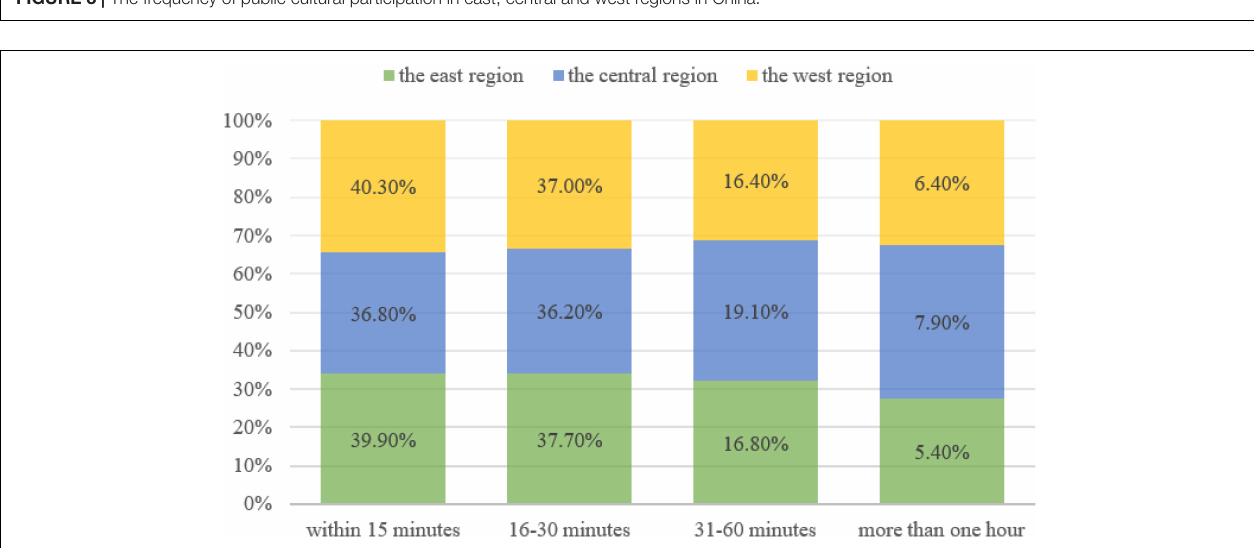
FIGURE 3 | The frequency of public cultural participation in east, central and west regions in China.